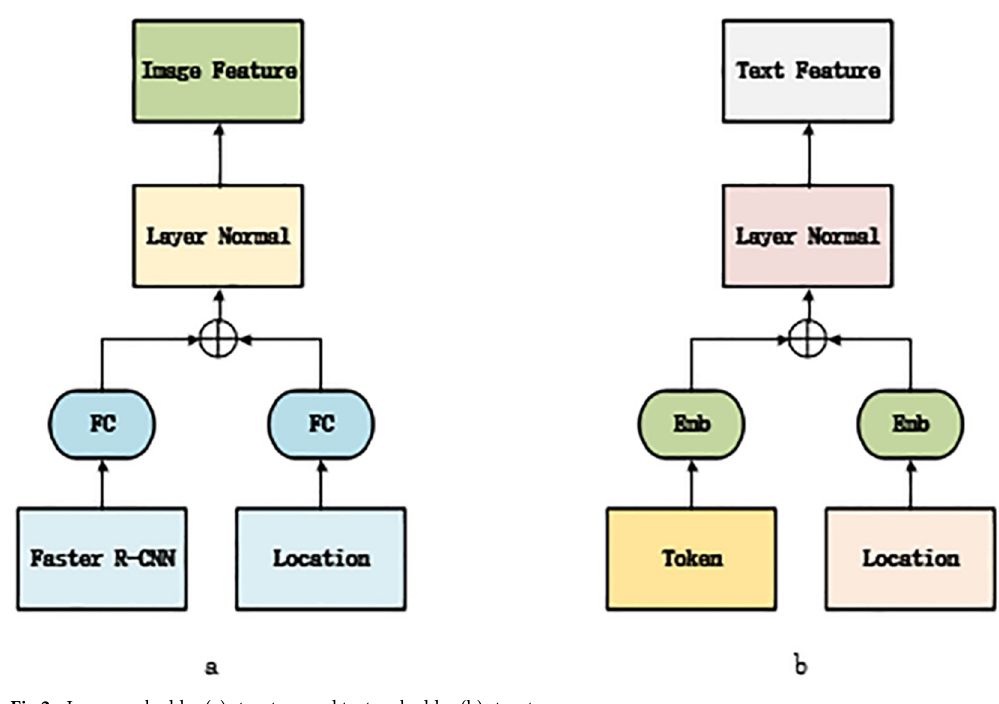
Fig 2. Image embedder (a) structure and text embedder (b)